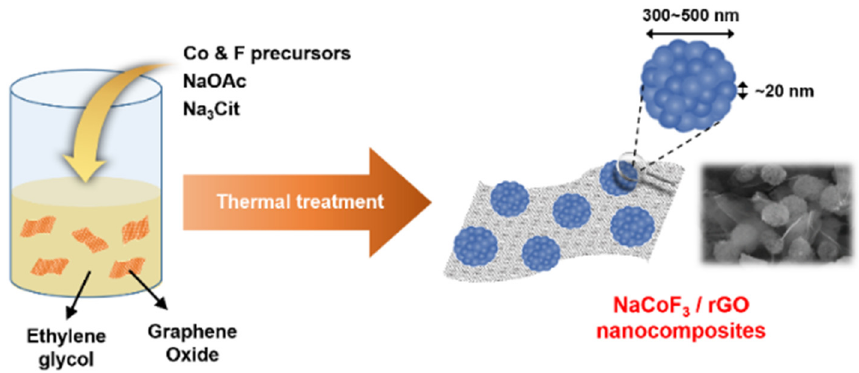
Figure 1. Schematic of the solvothermal synthesis of NCF/rGO